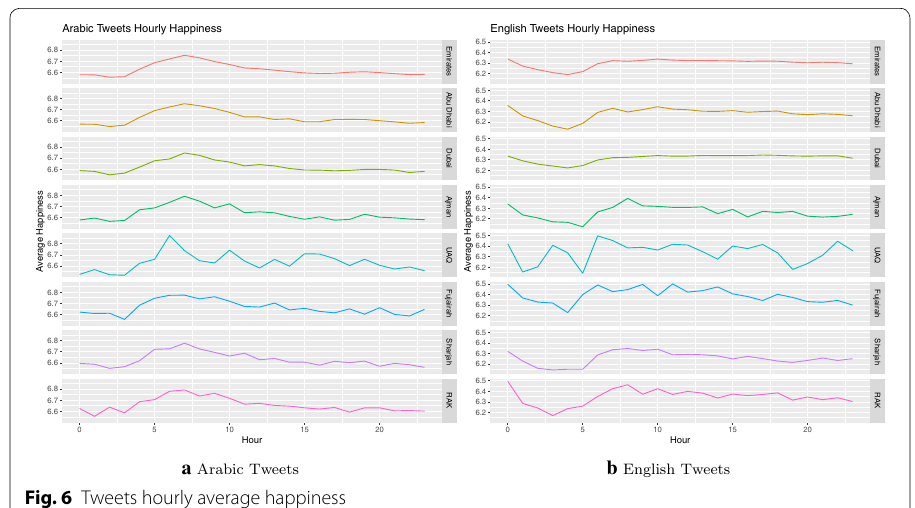
Fig. 6 Tweets hourly average